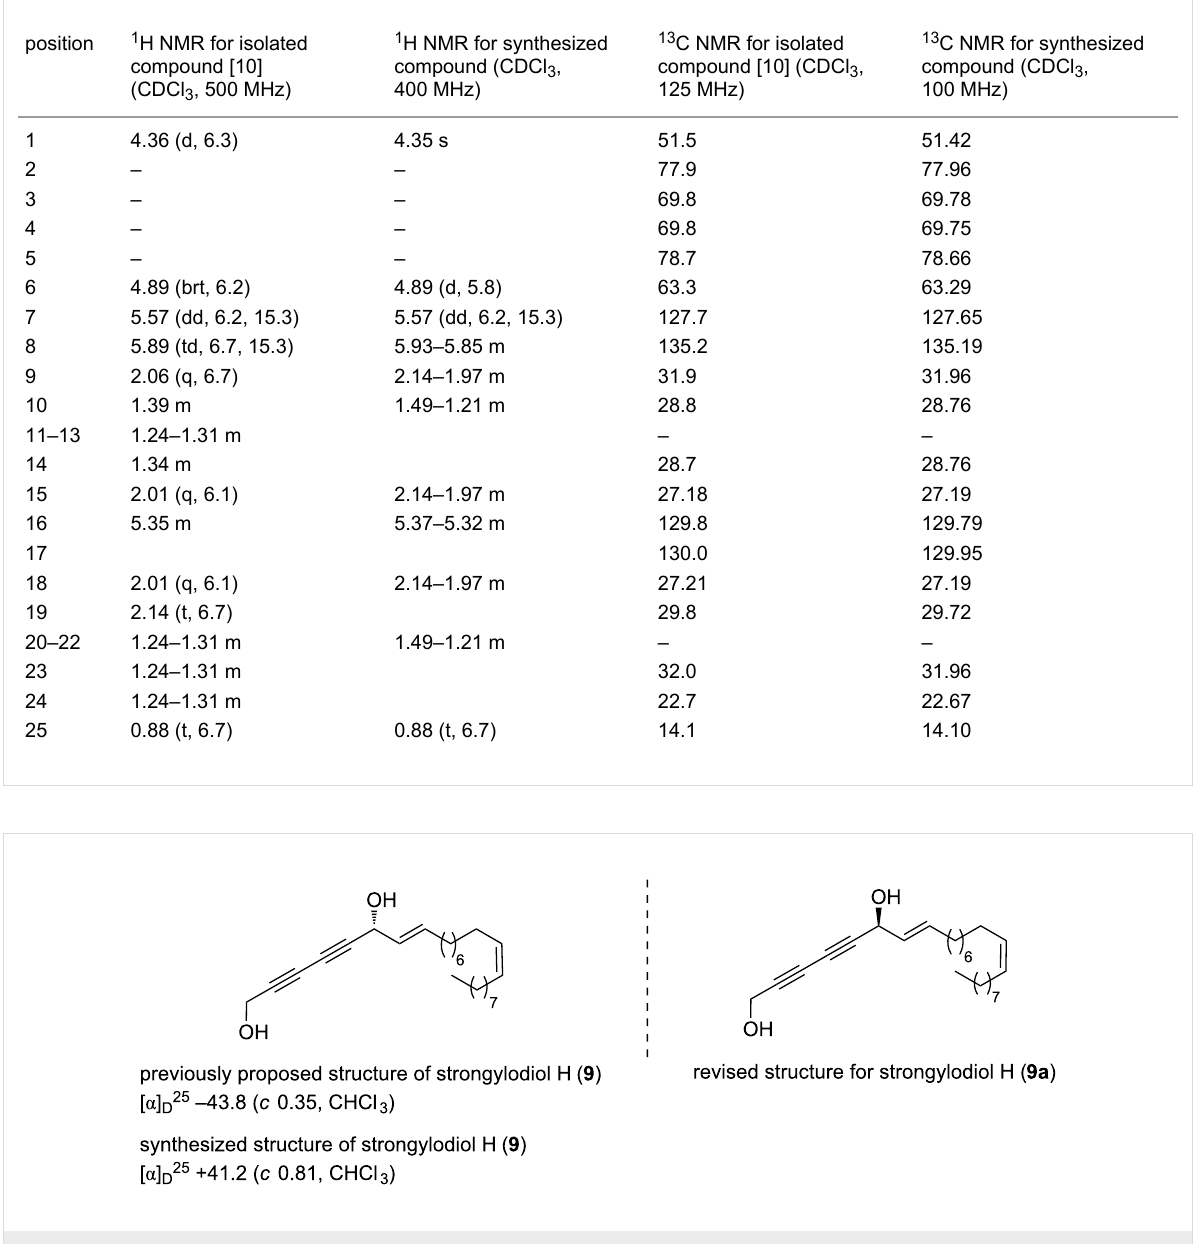
Figure 3: Previously proposed and revised structure of strongylodiol H ( 9